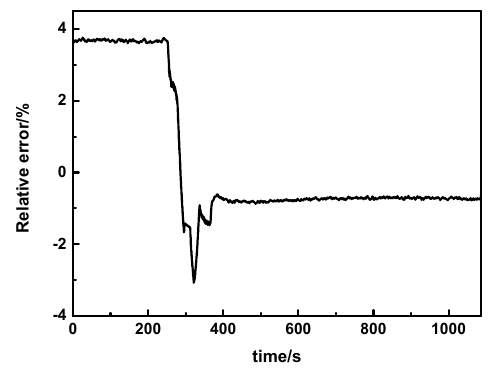
Figure 8. Relative error curve of on − site data and simulation data.